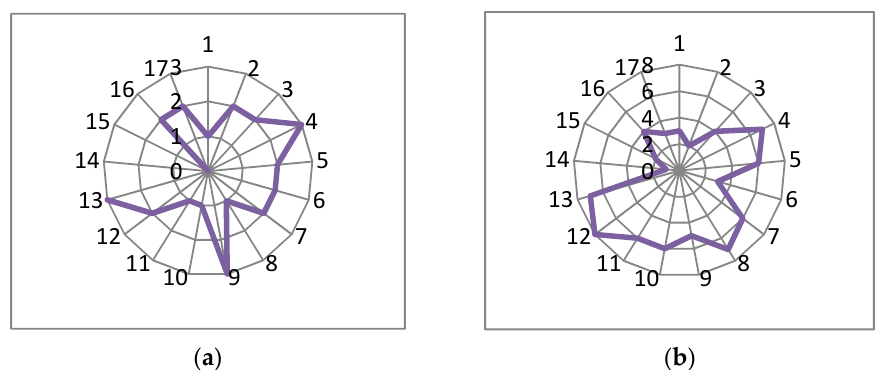
Figure 3. ( a ) Hungary’s level of achievement; ( b ) Hungary’s companies’ coverage of the SDGs (incident rate in COPs).